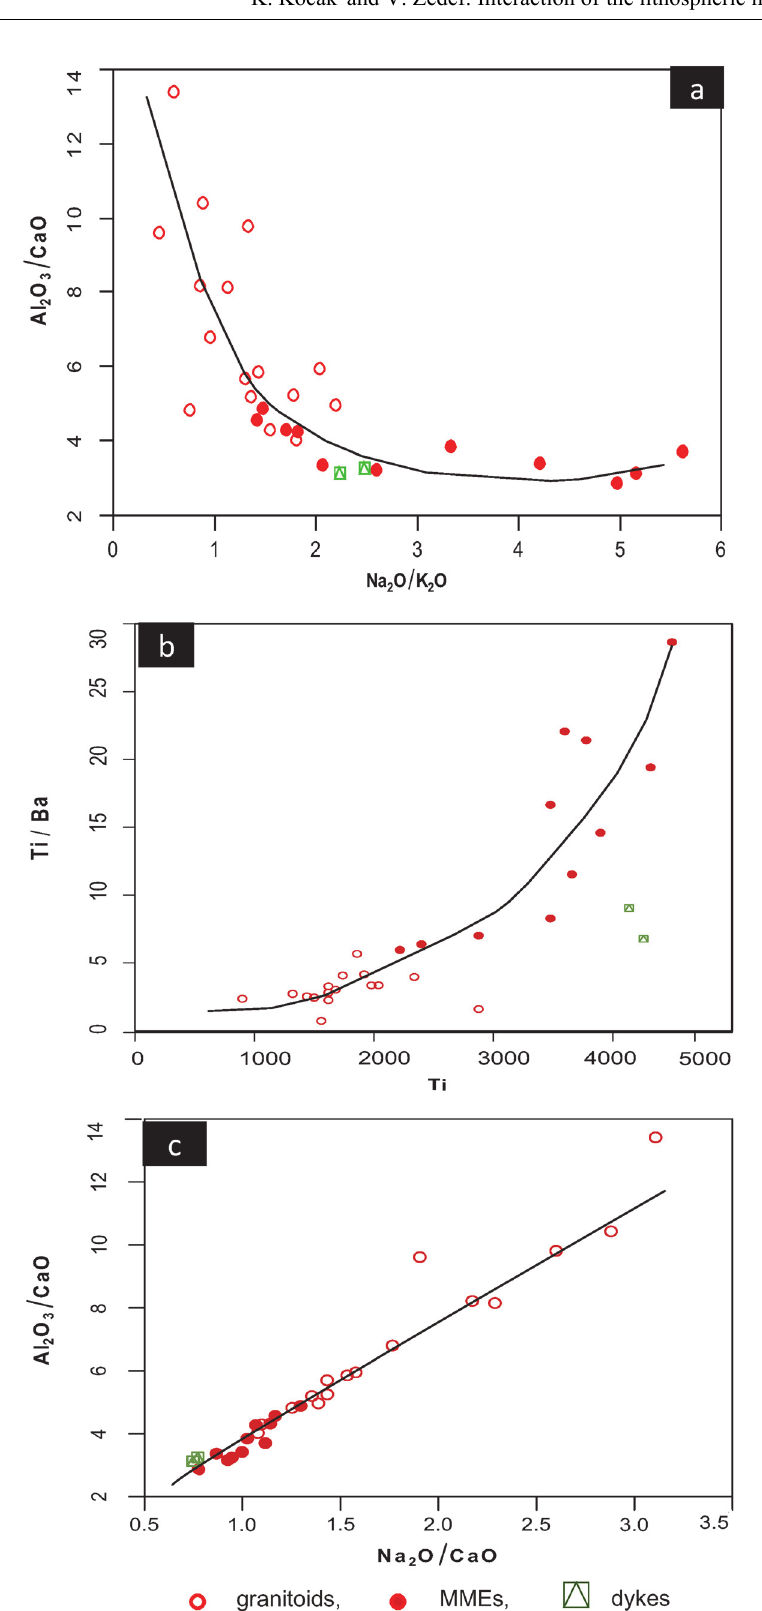
Fig. 9. Ratio–ratio (a and c) and ratio–element (b)